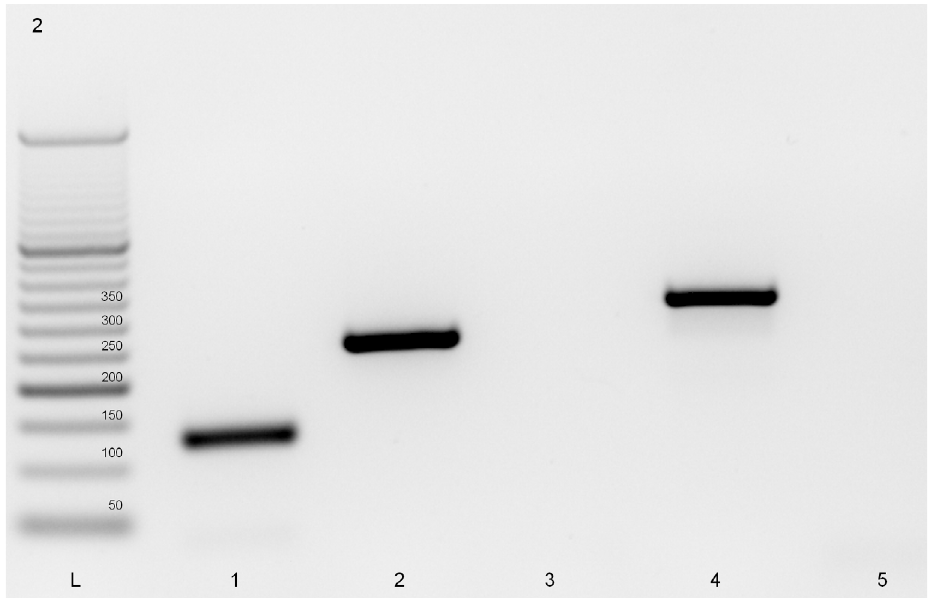
Figure 2. Electrophoretic pro fi les of Trichinella murrelli uniplex PCR ampli fi cations.DNA from T. murrelli (isolate code ISS35) reference larvae was used. Lane L= 50bp ladder. The genes targeted were the Expansion Segment V (ESV, lane 1), Internal Transcribed Spacer 1 II (ITS1 II, Lane 2), ITS1 III (lane 3), ITS2 IV (lane 4), and ITS2V (lane